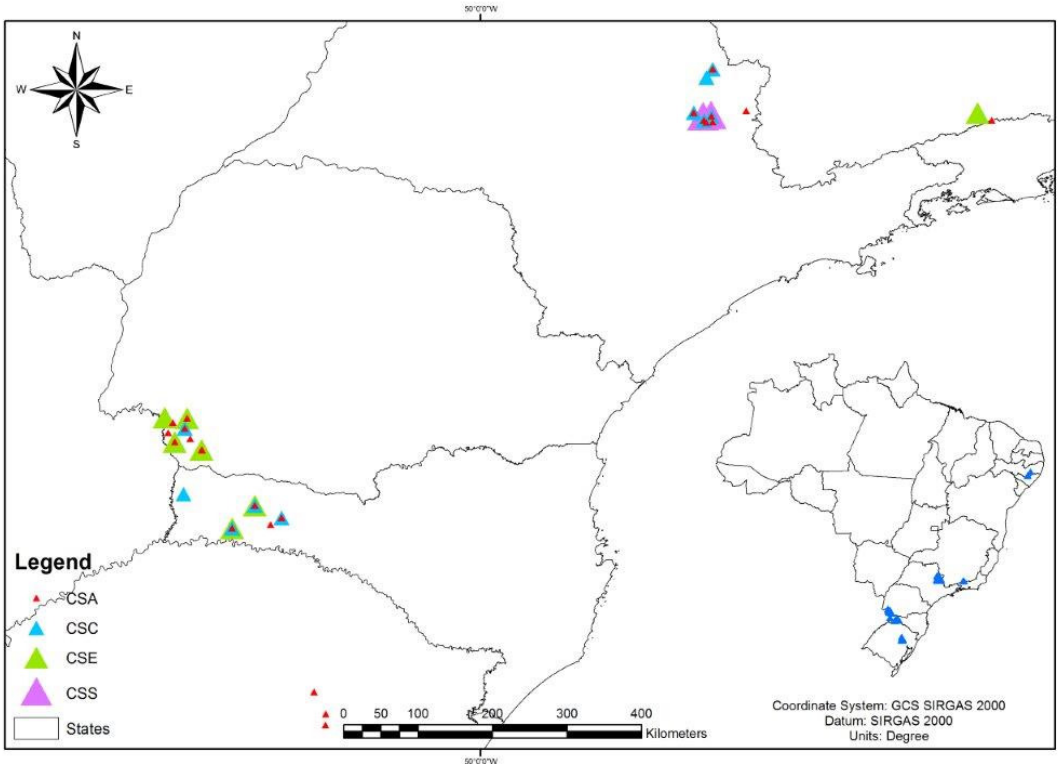
Figure 7. Map with the spatial distribution of the clusters of different Staphylococcus species analyzed by PFGE. CSA: cluster S. aureus ; CSC: cluster S. chromogenes ; CSE: cluster S. epidermidis ; CSS: cluster S. saprophyticus .